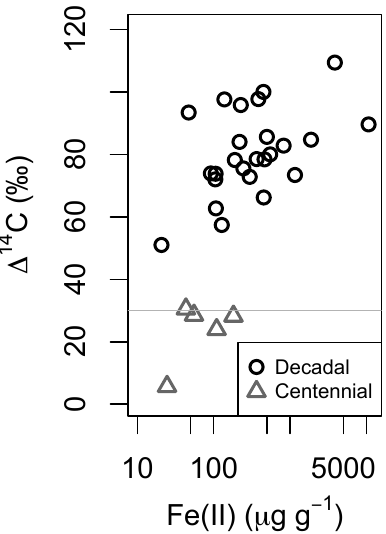
Figure 4. Soil (cid:49) 14 C vs. Fe(II) concentrations measured in 0.5M HCl extractions conducted in the field ( R 2 = 0 . 35, p< 0 . 001). Re- duced Fe was the best single correlate of (cid:49) 14 C and slow-pool turnover times; Fe(II) correlated positively with turnover times. Cir- cles indicate samples with the majority of C in the decadal-cycling slow pool; triangles indicate samples dominated by passive C of centennial to millennial age. The relationship between (cid:49) 14 C and C turnover was qualitatively different between these groups of sam- ples; increased (cid:49) 14 C implied longer turnover times for the circles, and smaller (cid:49) 14 C implied longer turnover for the triangles. The grey horizontal line indicates the approximate (cid:49) 14 C of the 2012 atmosphere in Northern Hemisphere zone